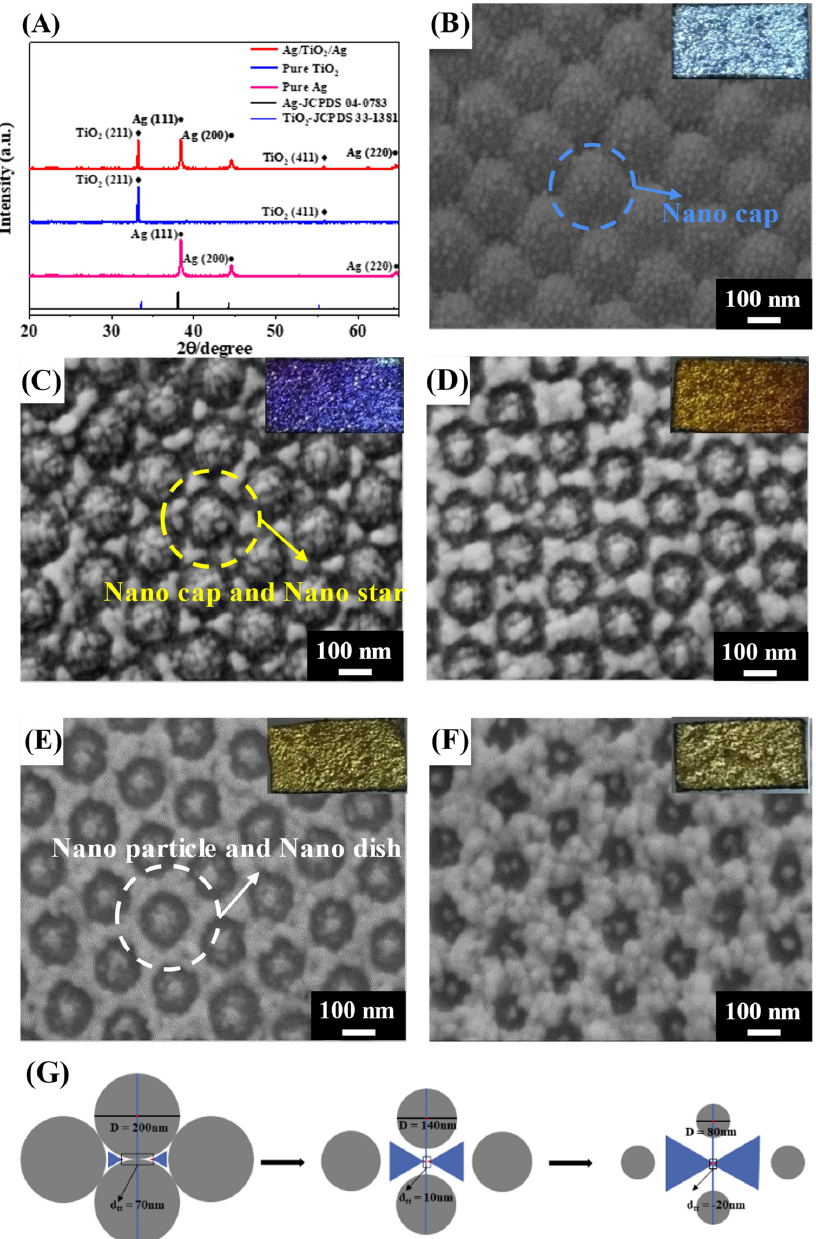
Figure 2. Characterization of composition and morphology of different structures and schematic diagram of their evolution. ( A ) XRD diagram of the Ag/TiO 2 /Ag nano structures, the crystal faces of Ag and TiO 2 are marked with different labels respectively. ( B – F ) The SEM of the Ag/TiO 2 /Ag nano structural arrays. ( B ) Etching 0 s. ( C ) Etching 60 s. ( D ) Etching 120 s. ( E ) Etching 180 s. ( F ) Etching 240 s. ( G ) The evolution of NCS to NCR.